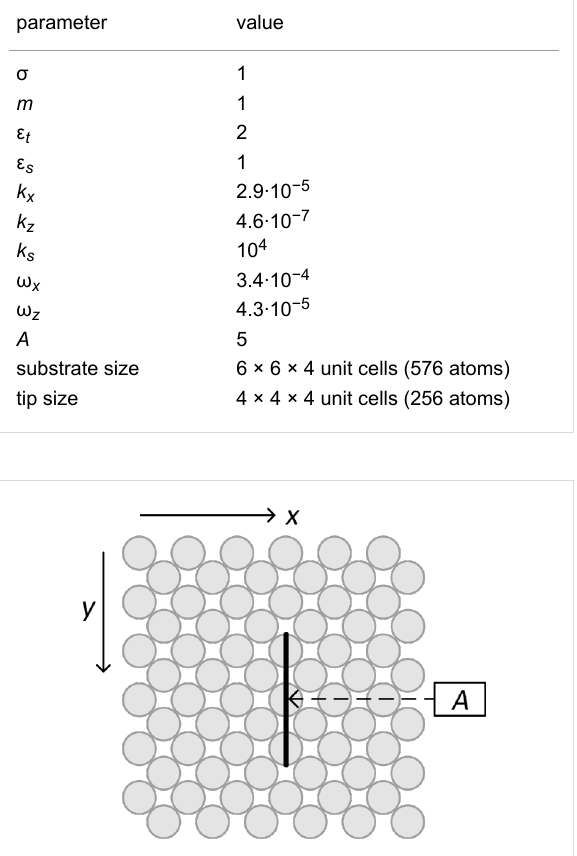
Table 1: Parameter set used for Lennard-Jones case, given in reduced units. parameter